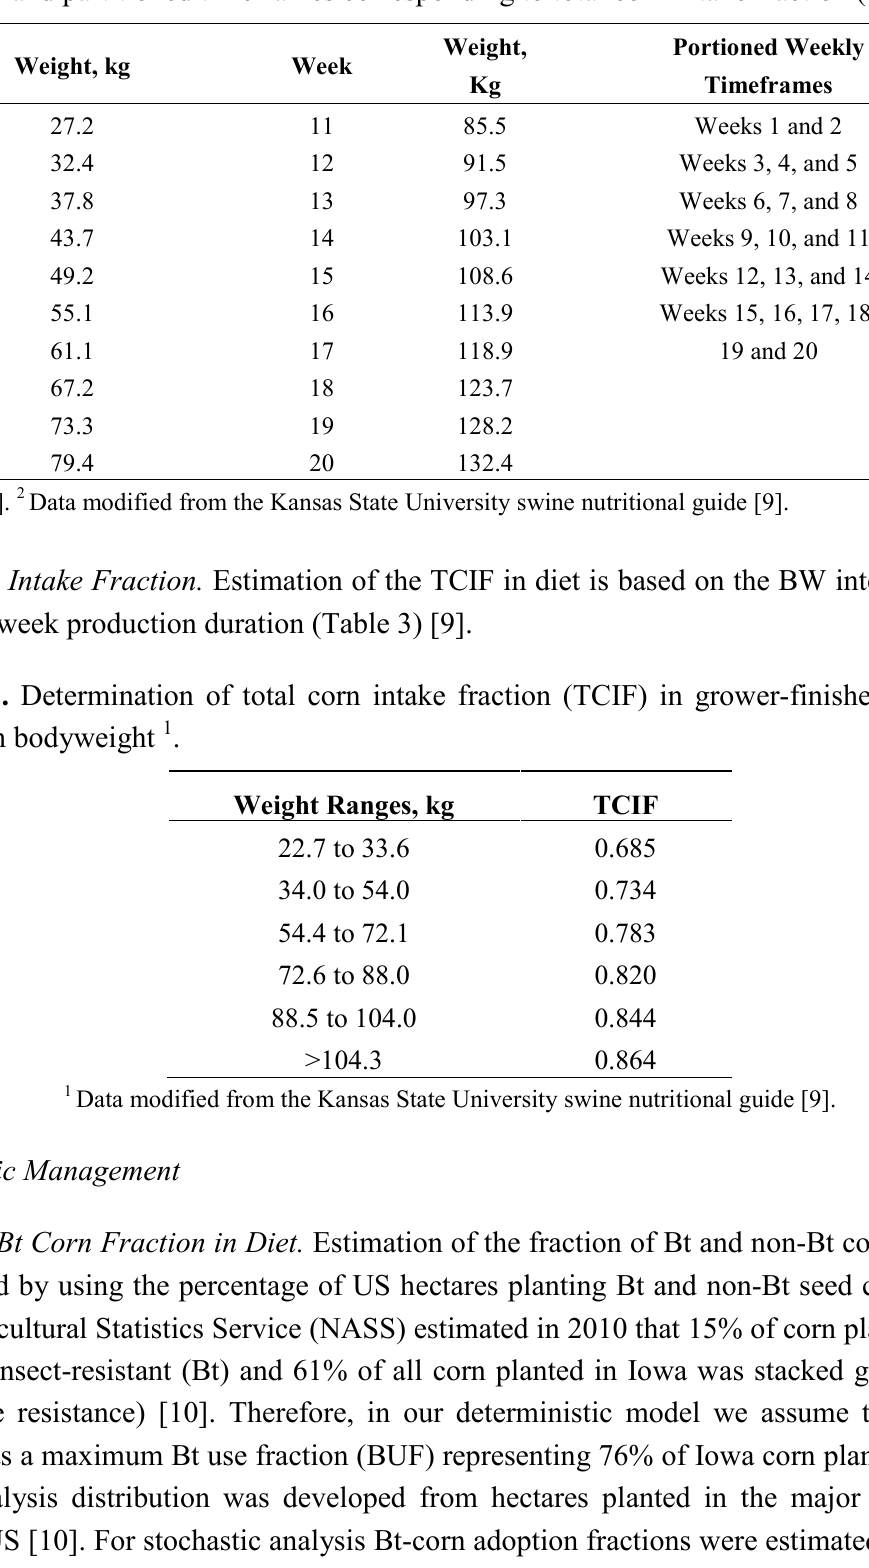
Table 2. Body weight estimates by weekly intervals during grower-finishing phase production as determined from the Kansas State growth and feed intake curve calculator